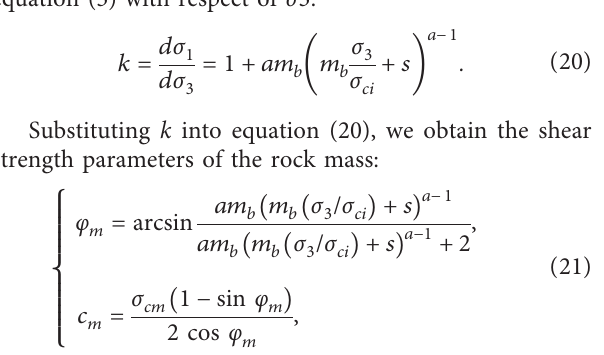
m with the porosity and σ